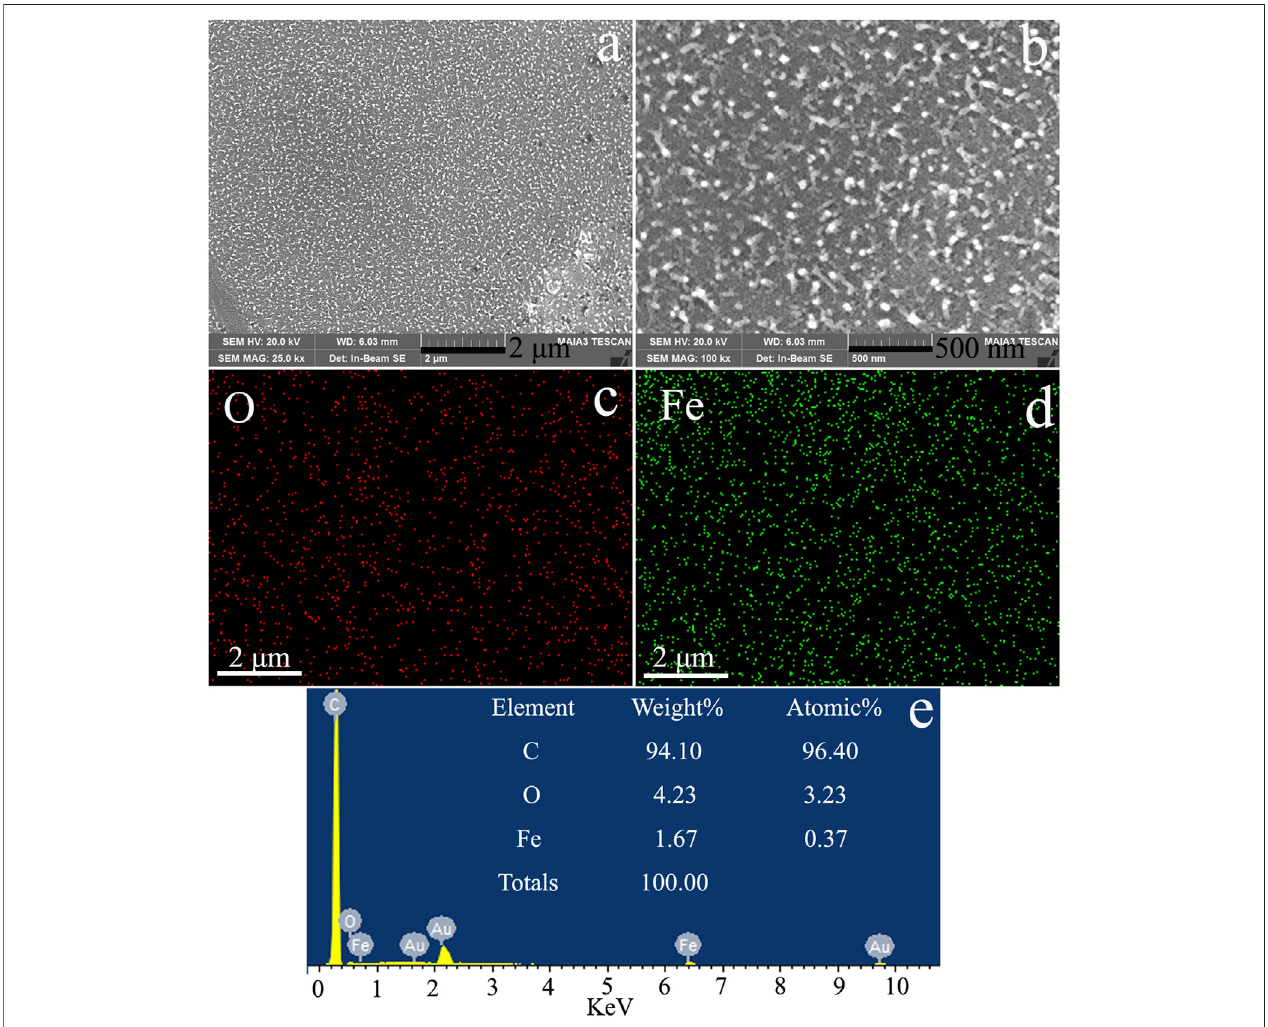
FIGURE 10 | The cross-sectional morphology of PS/Fe 3 O 4 : (A,B) SEM images, (C) and (D) EM images of O and Fe, and (E) EDS image.